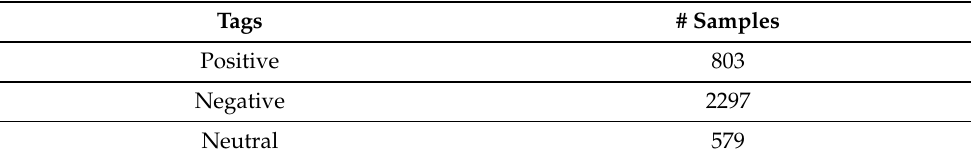
Table 3. Statistics of the dataset for task 1.